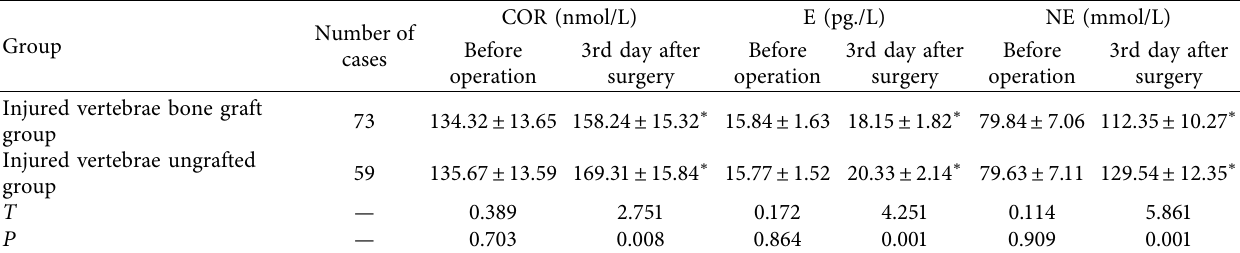
Table 3: Comparison of surgical stress levels between the two groups ( X ± S ).